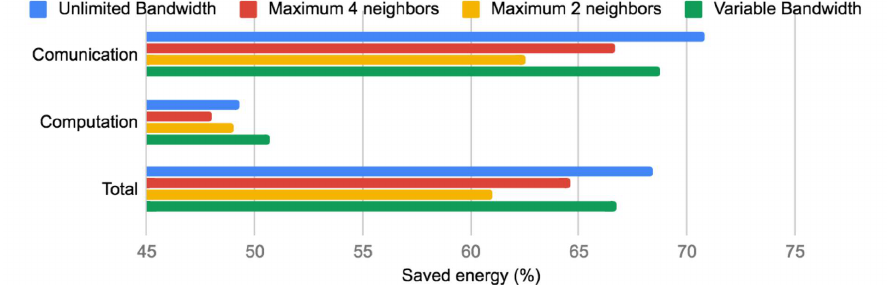
Figure 15. Percentages of energy saving respecting to the communication pattern without using out